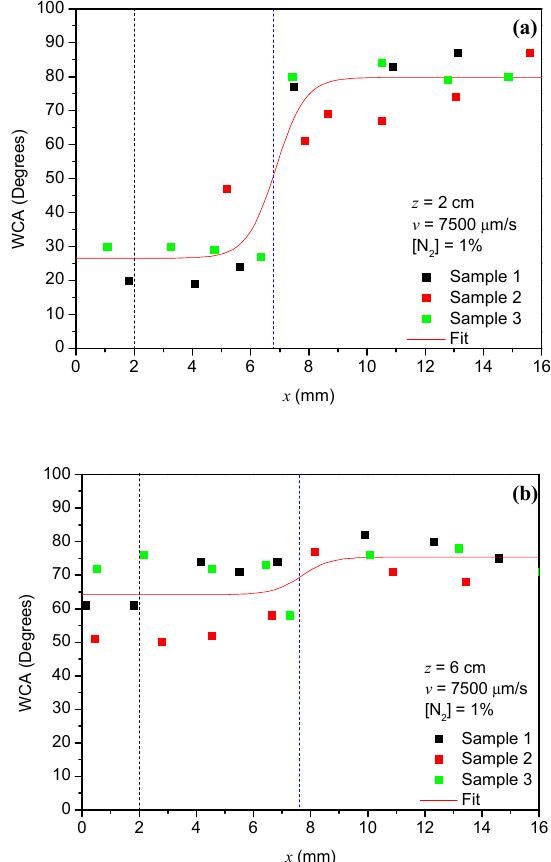
Figure 8. Water contact angle profile after Ar-N 2 postdischarge treatment at different distances measured from the end of the discharge: ( a ) 𝑧 = 2 cm and ( b ) 𝑧 = 6 cm.